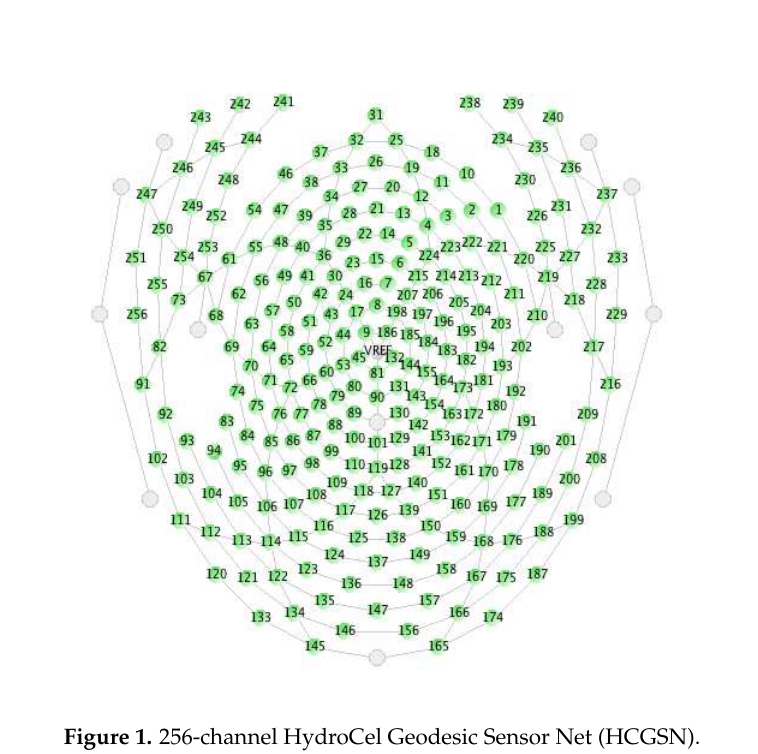
Figure 1. 256-channel HydroCel Geodesic Sensor Net